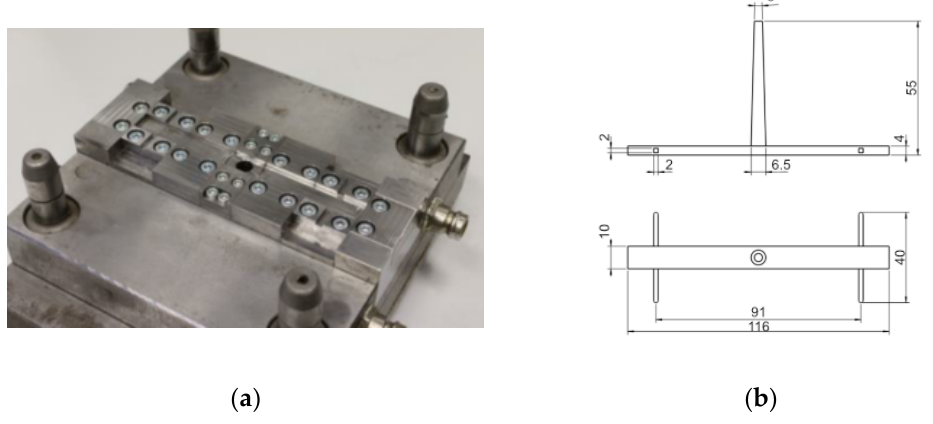
Figure 2. ( a ) Gate-side mold half of the modular injection mold. ( b ) Technical drawing of the specimen geometry.